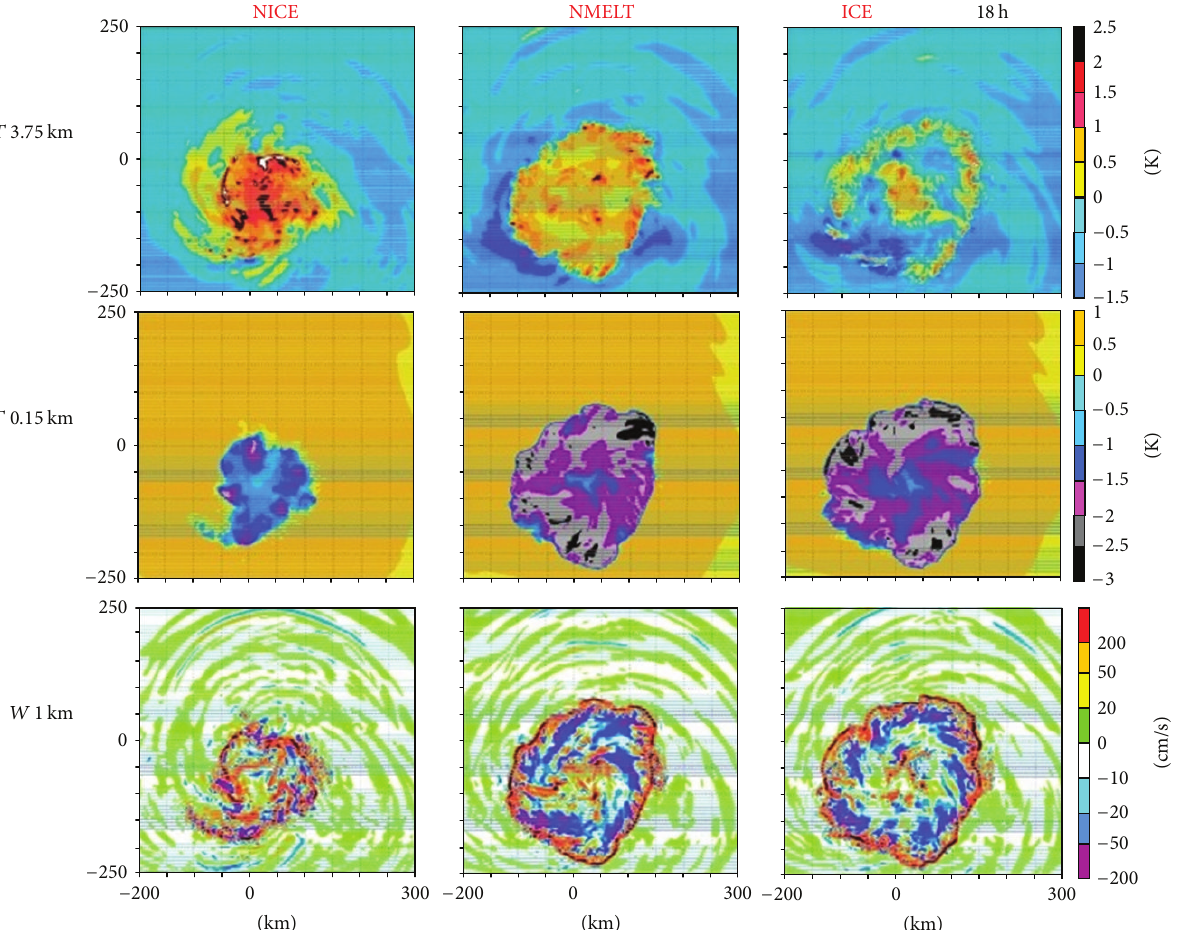
Figure 4: Comparison of the temperature anomaly at 3.75 km and 0.15 km and the vertical velocity at 1.0km in case NICE, case NMELT, and case ICE at